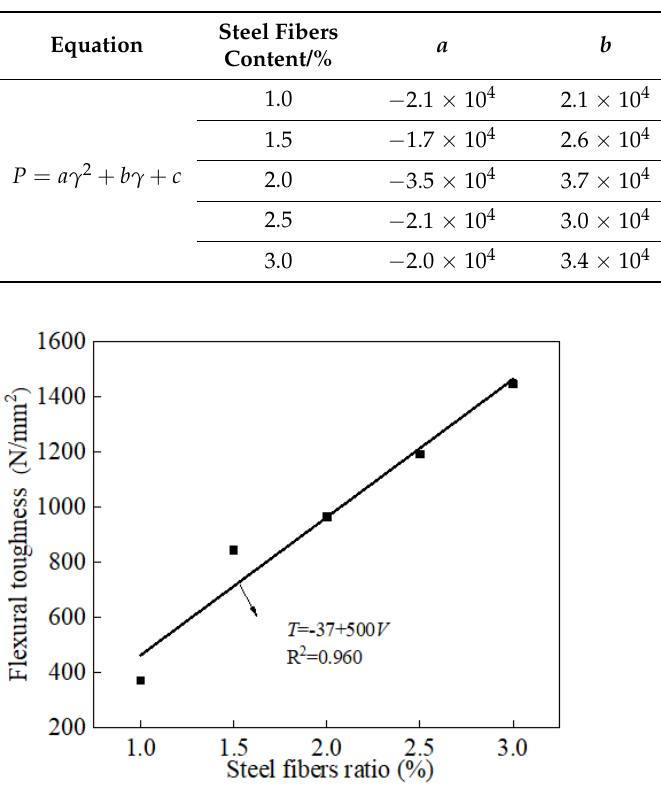
Figure 11. The flexural toughness of reactive powder concrete.